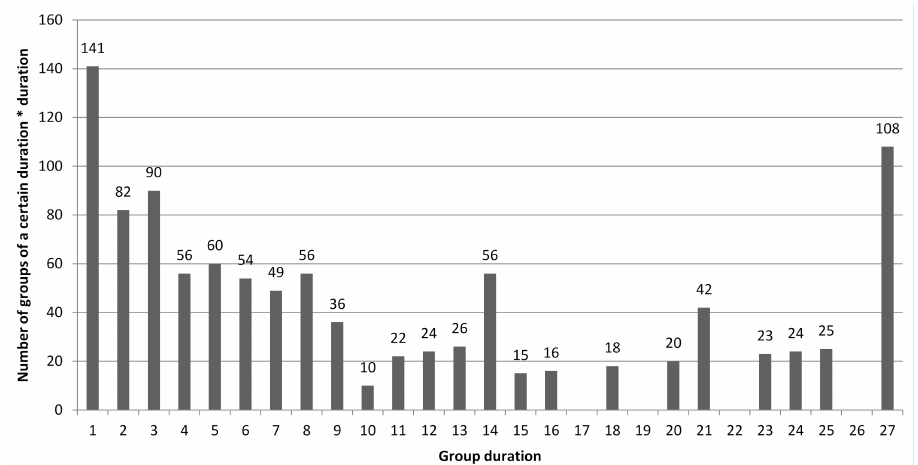
Figure 3. For each possible duration of a match, how many groups stick together for that amount of rounds times the duration of the